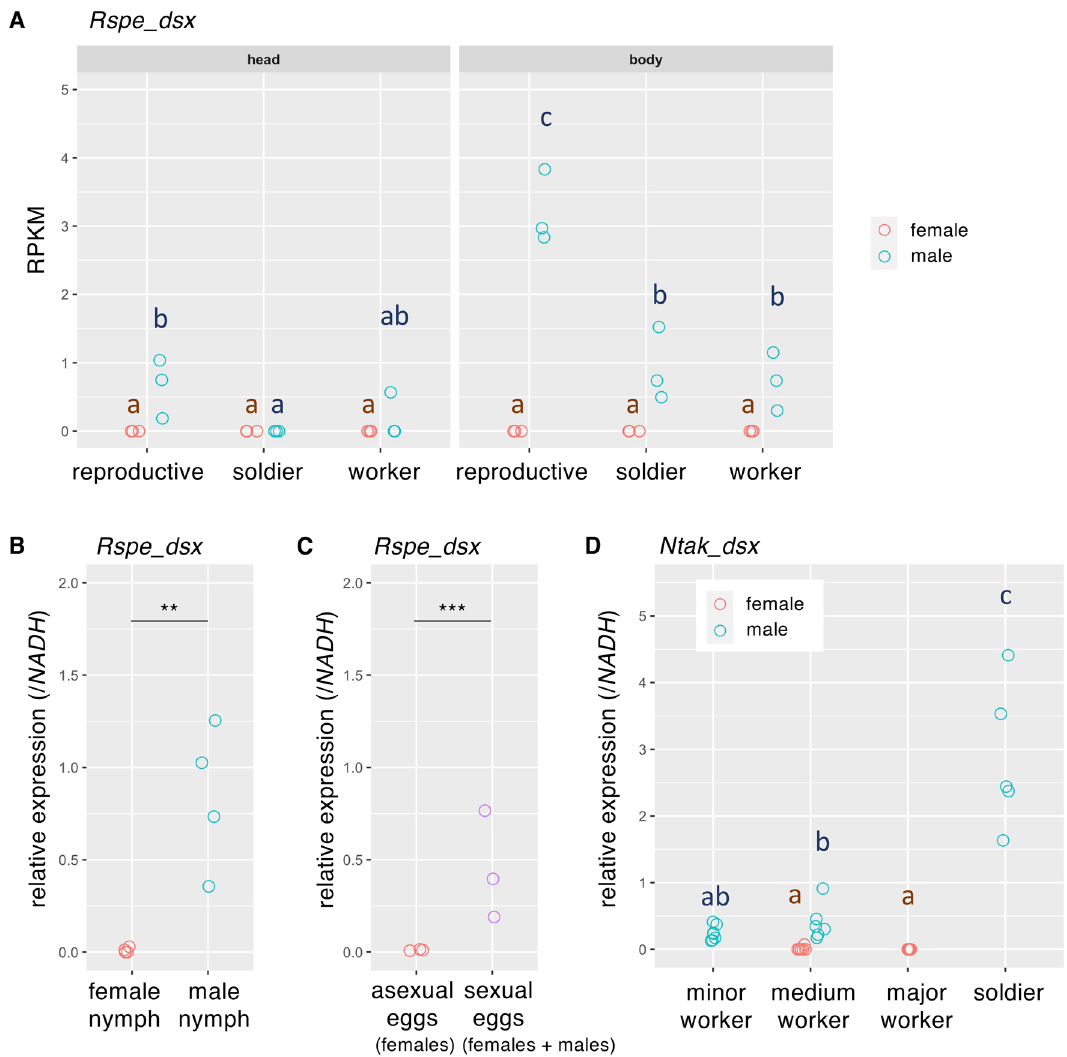
Figure 4. Sex-specific expression patterns of Rspe_dsx and Ntak_dsx . ( A ) Reads per kilo base per million mapped reads (RPKM) of Rspe_dsx in each sex and in each caste of R. speratus , which were re-analysed RNA- seq data (DRA010978, biological triplicates 21 ). ( B ) Rspe_dsx expression levels relative to those of NADH in female and male nymphs. All nymphs examined were collected from a single colony (i.e., siblings). ( C ) Relative Rspe_dsx expression in eggs produced asexually and sexually. The former are fated to develop into females, whereas the sexual fate of the latter was not determined. Total RNA was extracted from 30 eggs, and three RNA samples were derived from different colonies. ( D ) Ntak_dsx expression levels relative to those of NADH in each sex and in each caste of N. takasagoensis . All castes examined were collected from a single colony (i.e., siblings). In ( A ) and ( D ), the effects of sex, caste, and their interaction on gene expression levels were evaluated using GLM followed by multiple comparison using linear hypothesis testing with Tukey adjustment in the “multcomp” R package. Different letters indicate significant differences according to multiple comparison ( p < 0.05). In ( B ) and ( C ), relative expression levels of Rspe_dsx were compared between sexes using GLM analyses. ** and *** indicates p < 0.01 and 0.001 in GLM,